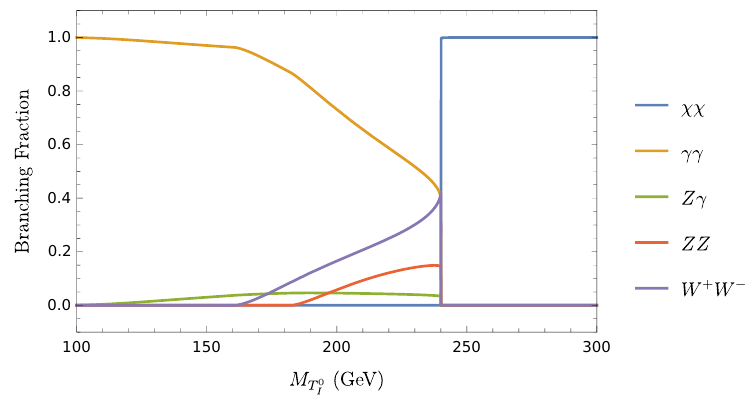
Figure 7 . Branching fractions for decay of the pseudoscalar triplet in benchmark